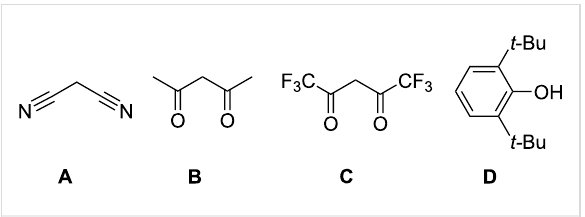
Figure 1: Active methylene compounds used for the preparation of gem -dithiolates.